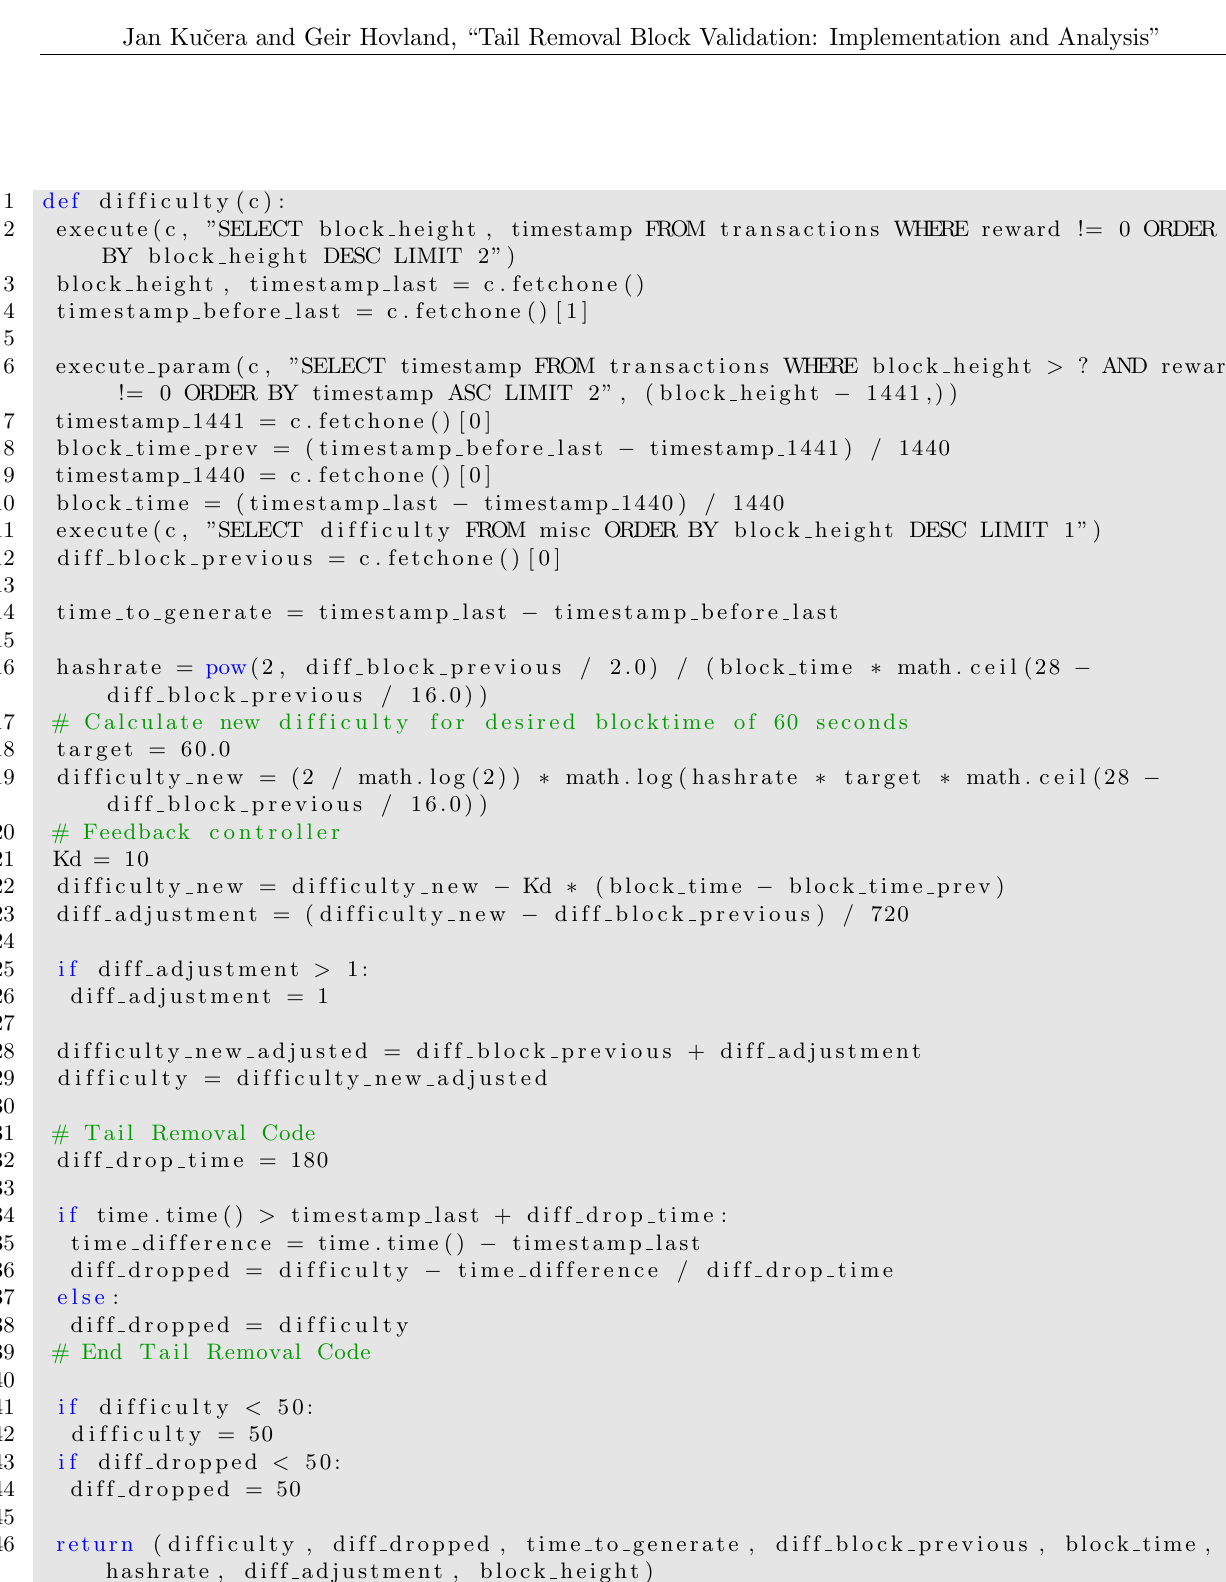
Figure 3: Difficulty calculation function (feedback controller) with the single block difficulty drop